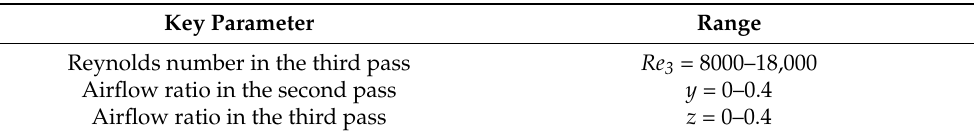
Table 3. Range of key